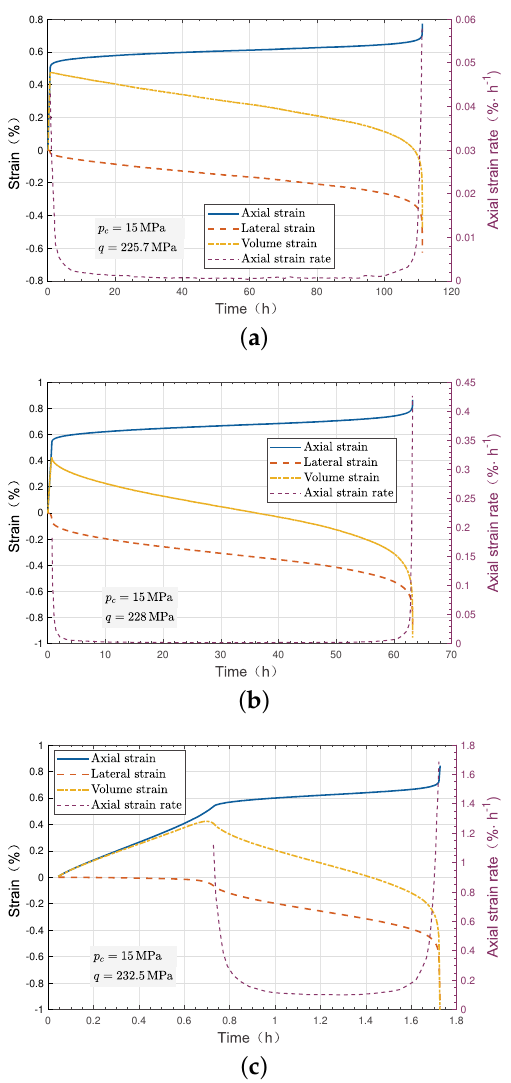
Figure 3. The single creep curves of Beishan granite under different levels of deviatoric stress with the confining pressure p c = 15 MPa. ( a ) q = 225.7 MPa; ( b ) q = 228 MPa; ( c ) q = 232.5